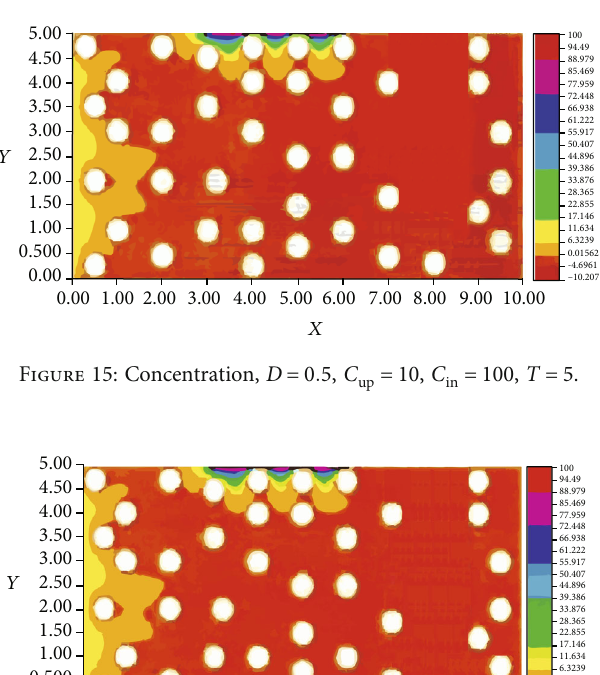
= 50 , C = 100 , T = 5 . up in